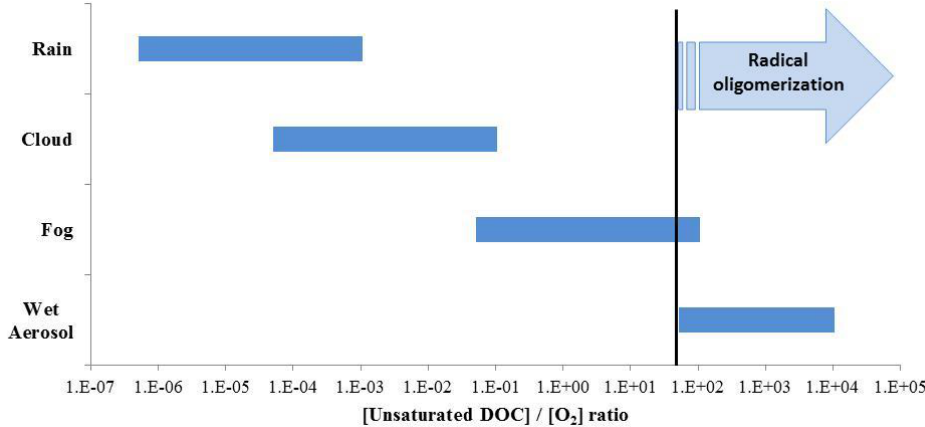
Fig. 12 : Estimated ranges of the ratios of unsaturated dissolved organic carbon concentration to oxygen concentration (in M M -1 ) in atmospheric waters. The straight lines delimit the values for which radical oligomerization dominates over O 2 addition, as determined by the present work (see text).